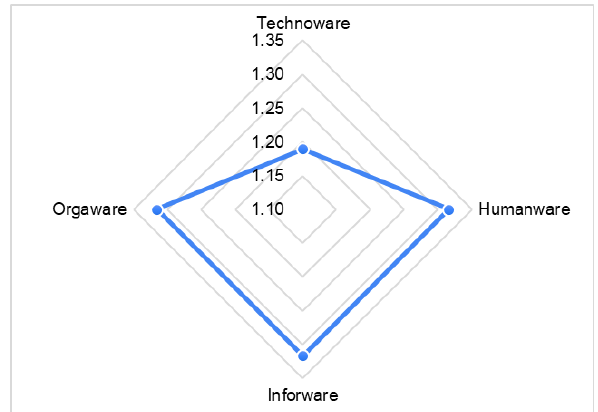
Figure 6. Radar diagram for the technology contribution coefficient.